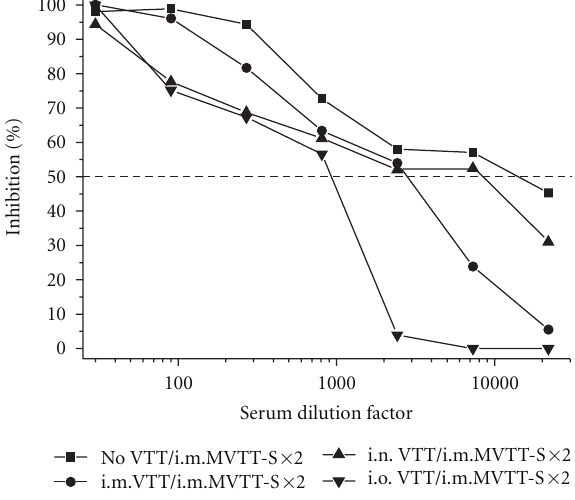
Figure 3: Anti-S neutralizing antibody responses in VTT-vaccinat- ed mice after two i.m. MVTT-S challenges. Serum samples collected three weeks after the second MVTT-S challenge were tested in this experiment. Pooled sera, which contain an equal amount of serum of each vaccinated mouse in each group, were subjected to each experiment. The X -axis represents the serum dilution factor whereas the Y -axis indicated the percentage of viral inhibition. The dashed horizontal line indicates IC 50 values. The experiment was repeated twice with similar results obtained. As controls, no VTT represents mice, who did not receive